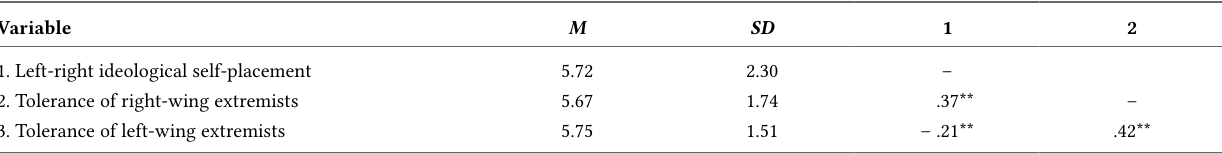
Descriptive Statistics and Pearson Correlations for the Continuous Variables in Experiment 1 Variable M SD 1